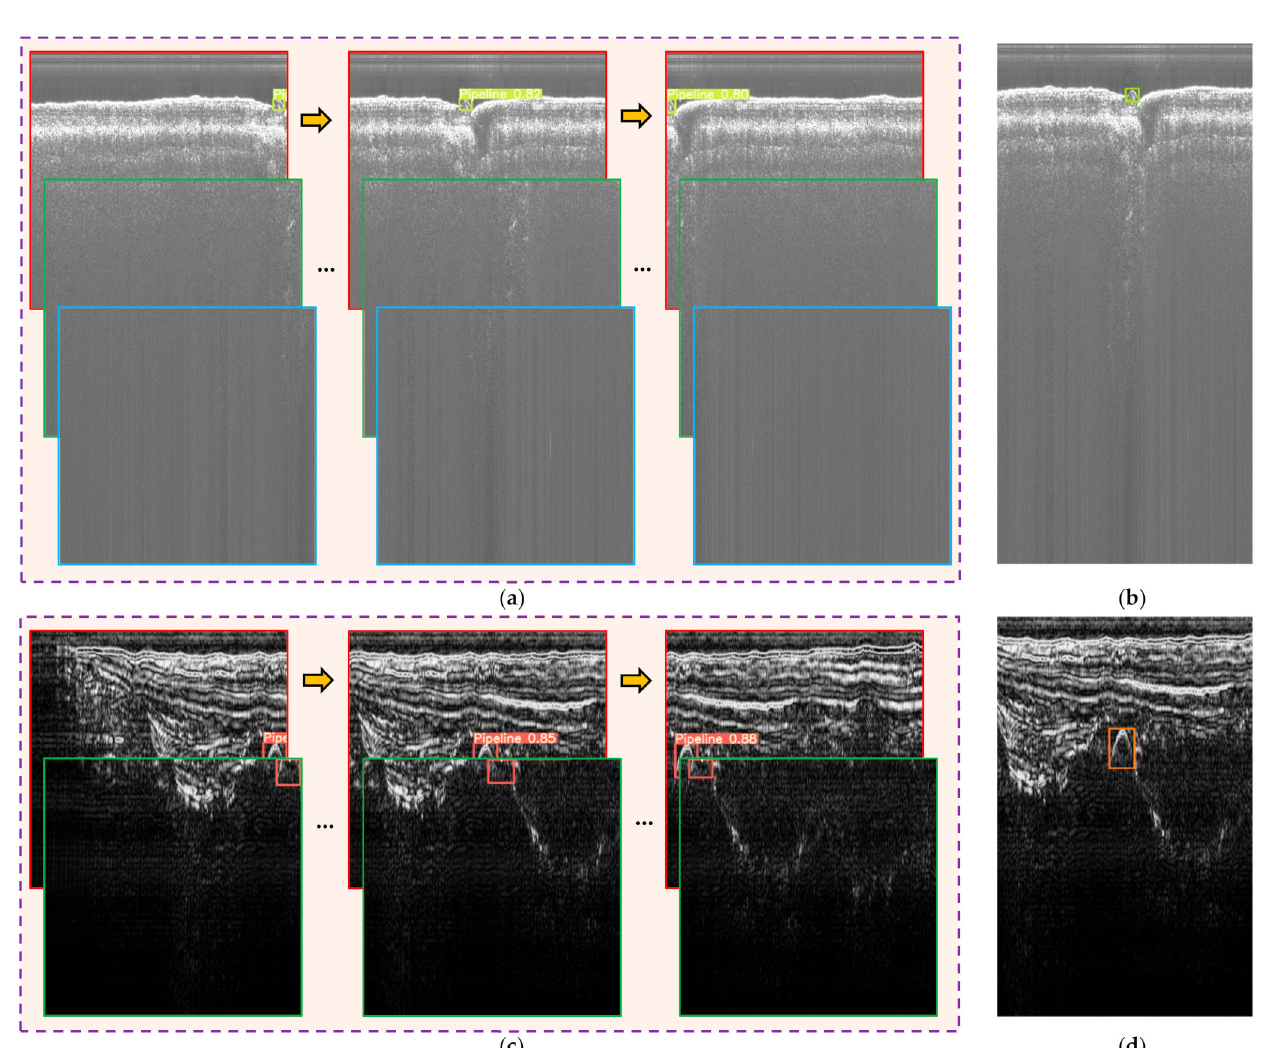
Figure 27. Part of the real-time detection results of the two survey lines. ( a ) Part of the detection results of the same pipeline in survey line 1; ( b ) bounding box fusion result of the pipeline in survey line 1; ( c ) part of the detection results of the same pipeline in survey line 2; ( d ) bounding box fusion result of the pipeline in survey line